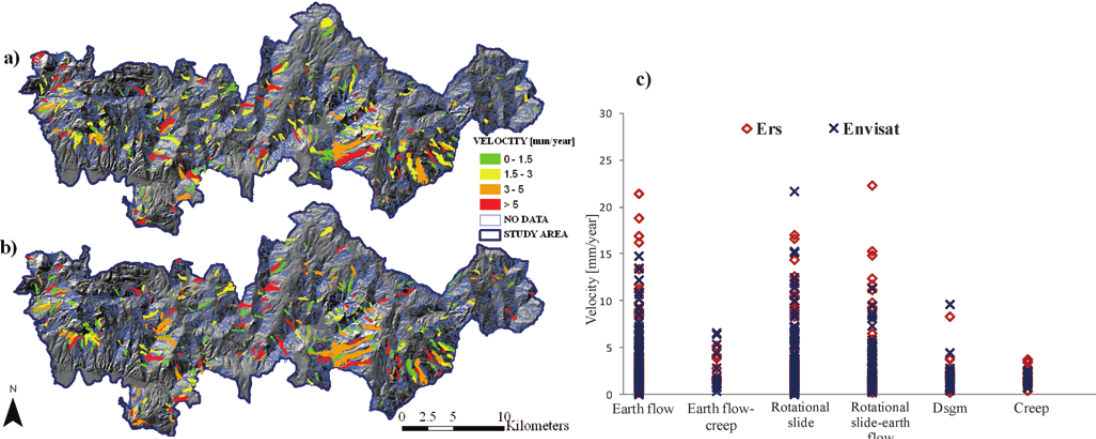
Fig. 15. The PSI landslide velocity map for ERS (a) and ENVISAT (b) data; (c) the computed landslide velocities per different landslide